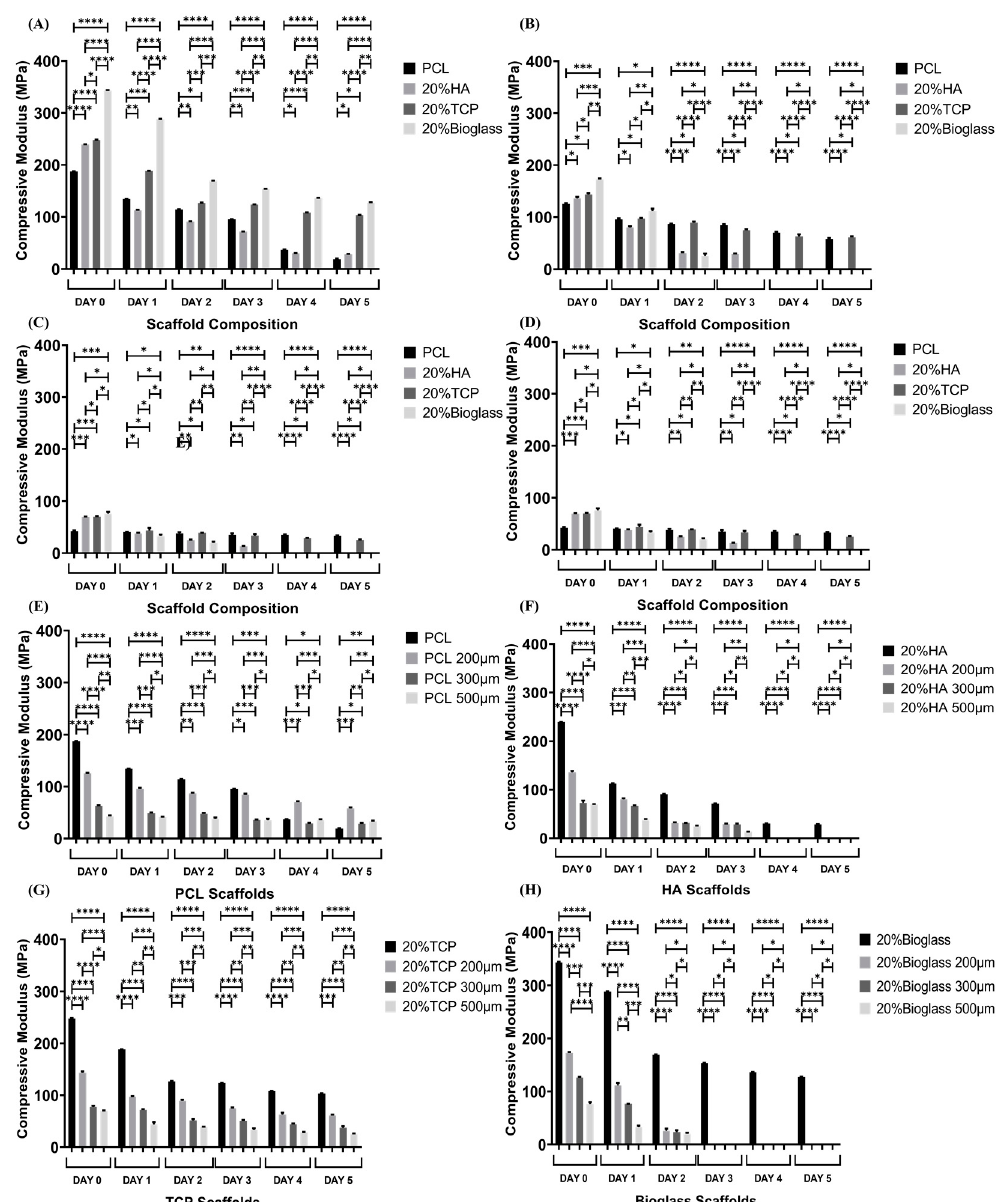
Figure 3. Compressive modulus as a function of degradation time for different architectures and material compositions. ( A ) Bone bricks scaffolds; ( B ) rectangular scaffolds with 200 μ m pore size; ( C ) rectangular scaffolds with 300 μ m pore size; ( D ) rectangular scaffolds with 500 μ m pore size; ( E ) PCL bone bricks and rectangular scaffolds; ( F ) HA bone bricks and rectangular scaffolds; ( G ) TCP bone bricks and rectangular scaffolds; and ( H ) bioglass bone bricks and rectangular scaffolds. * Sta- tistical evidence (p < 0.05) analysed by one-way ANOVA, and Tukey post hoc test. The * statistical evidence (p < 0.05), **, *** and **** is the one-way analysis of variance (one-way ANOVA) and